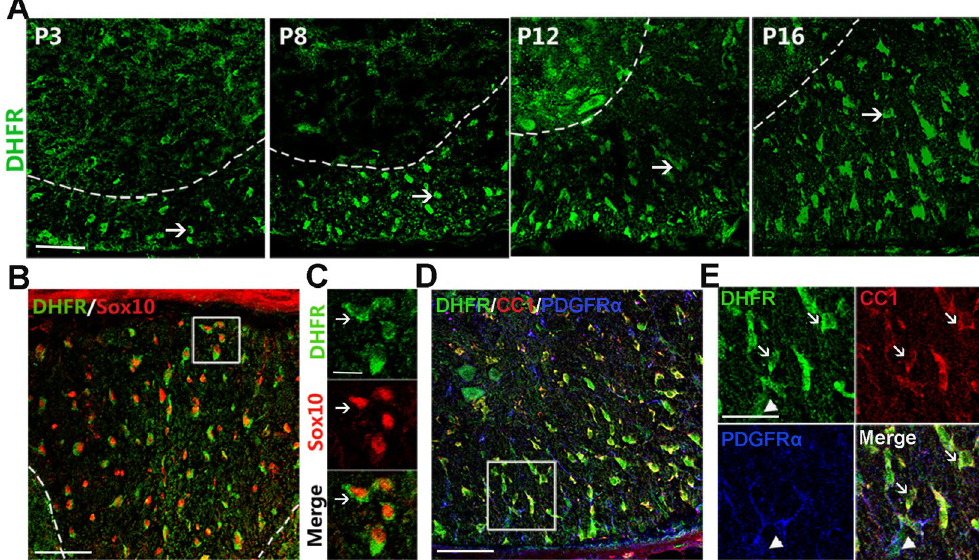
Figure 3. DHFR is highly expressed in oligodendrocytes. ( A ) Spinal cords isolated from the wild type mice immunostained with DHFR antibody at P3, P8, P12 and P16. The ventral parts showed in the images. ( B , C ) The spinal cord of wild type mice at P15 is immunostained for DHFR and Sox10. The dorsal part showed in the image. A high magnification of ( B ) is shown in ( C ). Arrows indicate co-labeled cells. ( D , E ) The spinal cord of wild type mice at P15 is immunostained for DHFR, CC1, and PDGFR α , respectively. The ventral part showed in the image. A high magnification of ( E ) is shown in ( F ). Arrows indicated DHFR + /CC1 + cells. Arrowhead indicated DHFR + /PDGFR α+ cells. Scale bars: 100 μ m ( A , B , D ), 40 μ m ( C , E